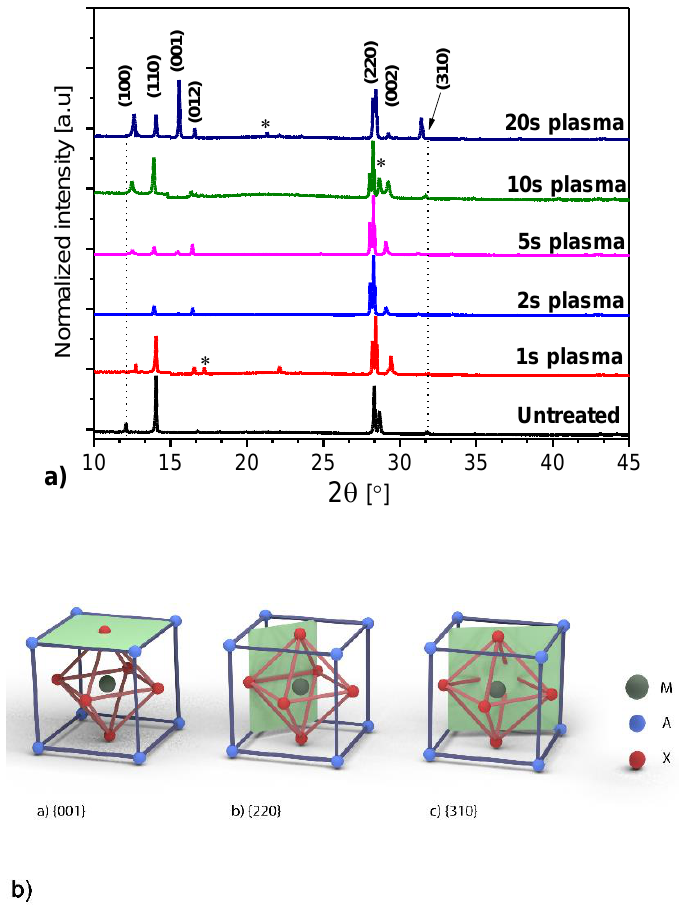
Figure 1. ( a ) XRD pattern of perovskite film before and after plasma treatment. Denoted peaks with * correspond to the intermediate phase. ( b ) The location of some perovskite planes in the unit cell.